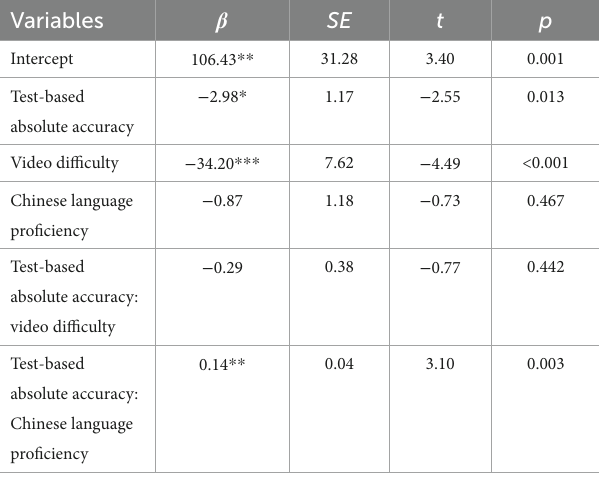
TABLE 3 Multiple regression of audiovisual comprehension performance based on test-based absolute